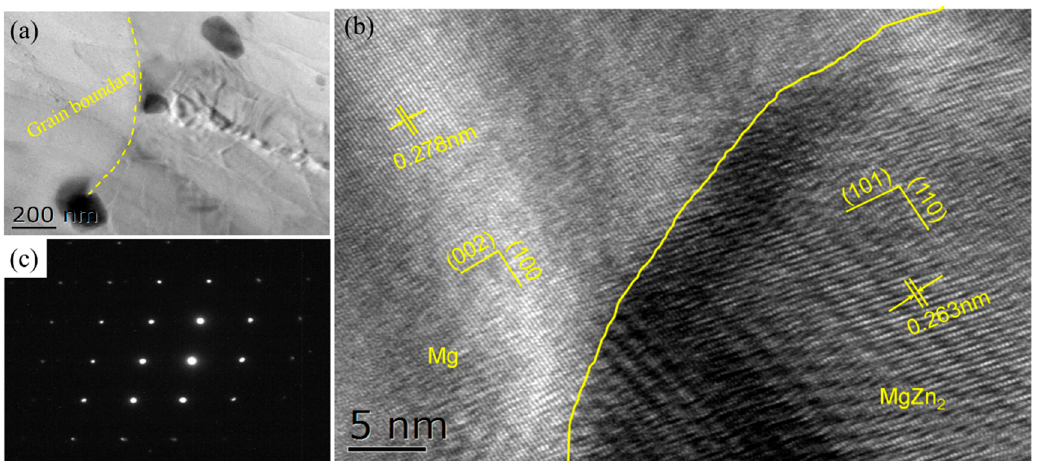
Figure 12. ( a , c ) EDS and ( b , d ) XRD of ( a , b ) the Mg-5Zn alloy and ( c , d ) the SiC p /Mg-5Zn material with different compression strains.